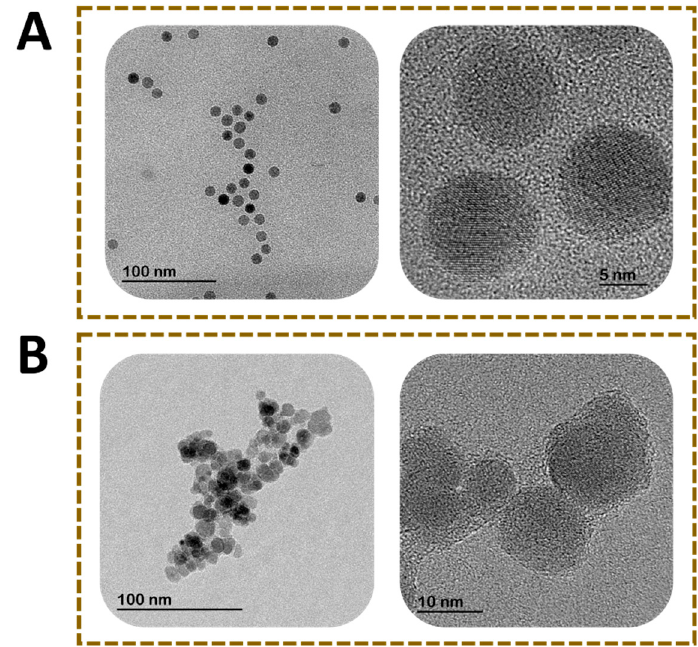
Figure 3. Transmission electron microscopy images of magnetite nanoparticles. ( A ) Monodisperse MNP with spherical shape and ( B ) polydisperse nanoparticles with irregular spherical shape.